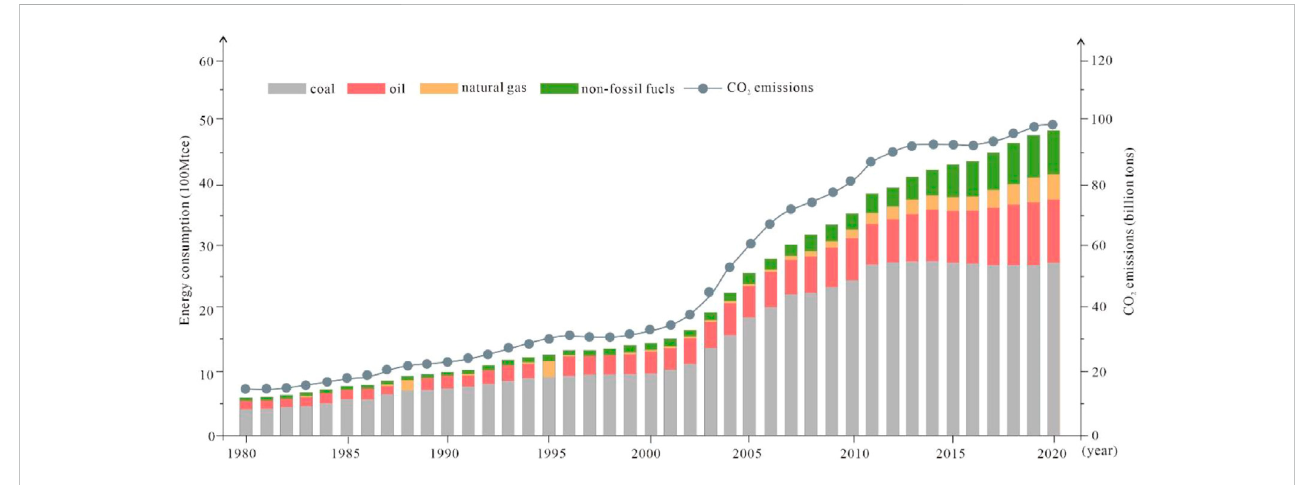
FIGURE 1 Trends of energy consumption and CO 2 emissions in China from 1980 to